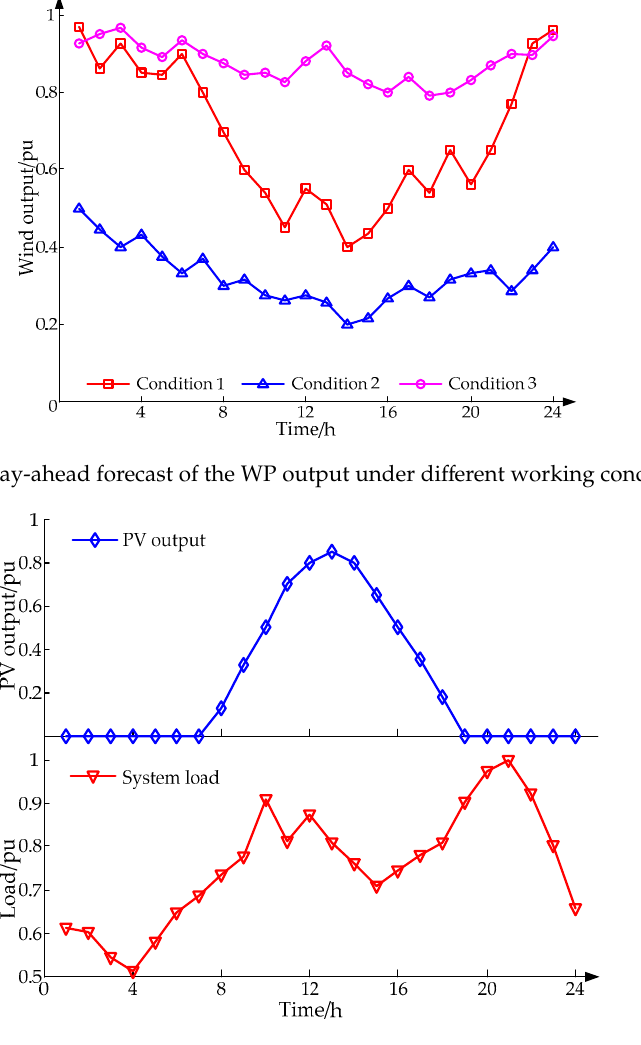
Figure 6. Day-ahead forecast of the PV output and load.